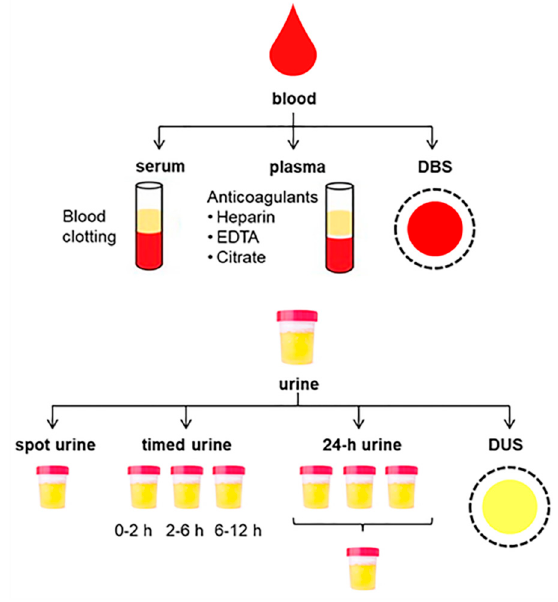
Figure 2. Summary of sampling alternatives for blood and urine collection.